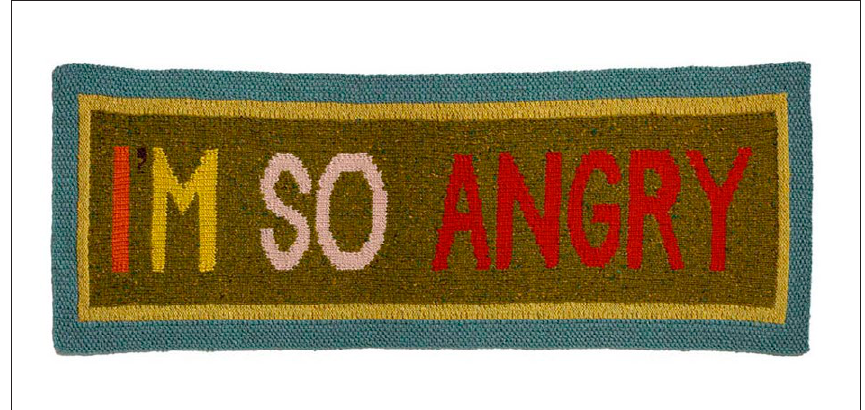
Figure 5: I’M SO ANGRY , 2005, hand knitted wool, 960 × 340 mm. Knitted for me by Jean Arkell. In the collection of KODE – Kunstmuseene i Bergen, Norway. Photograph: Douglas